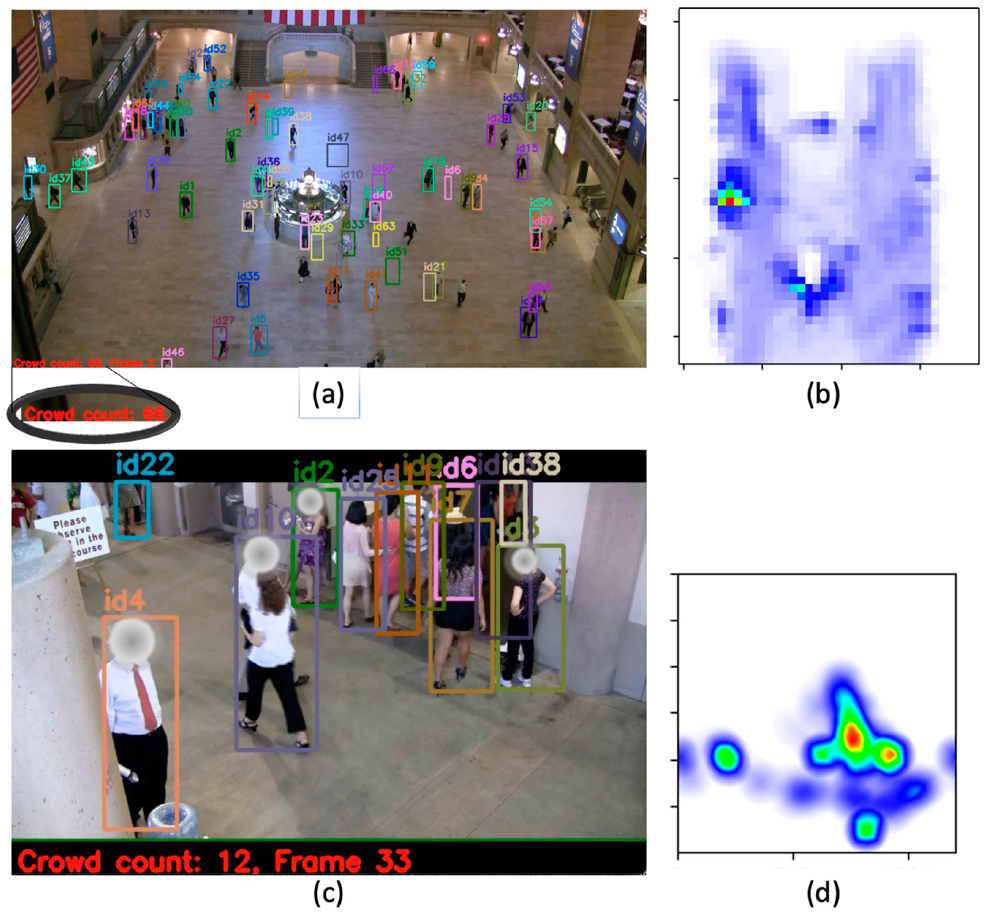
Figure 5. ( a ) Visualization including crowd count and individual monitoring at the Grand Central Station. ( b ) Real-time congestion visualization with highlighted congestion hotspots at the Grand Central Station. The density map colors range from blue to red with red being the highest density. ( c ) Visualization including crowd count and individual monitoring at the Stanford Stadium. ( d ) Real-time congestion visualization with highlighted congestion hotspots at the Stanford Stadium.